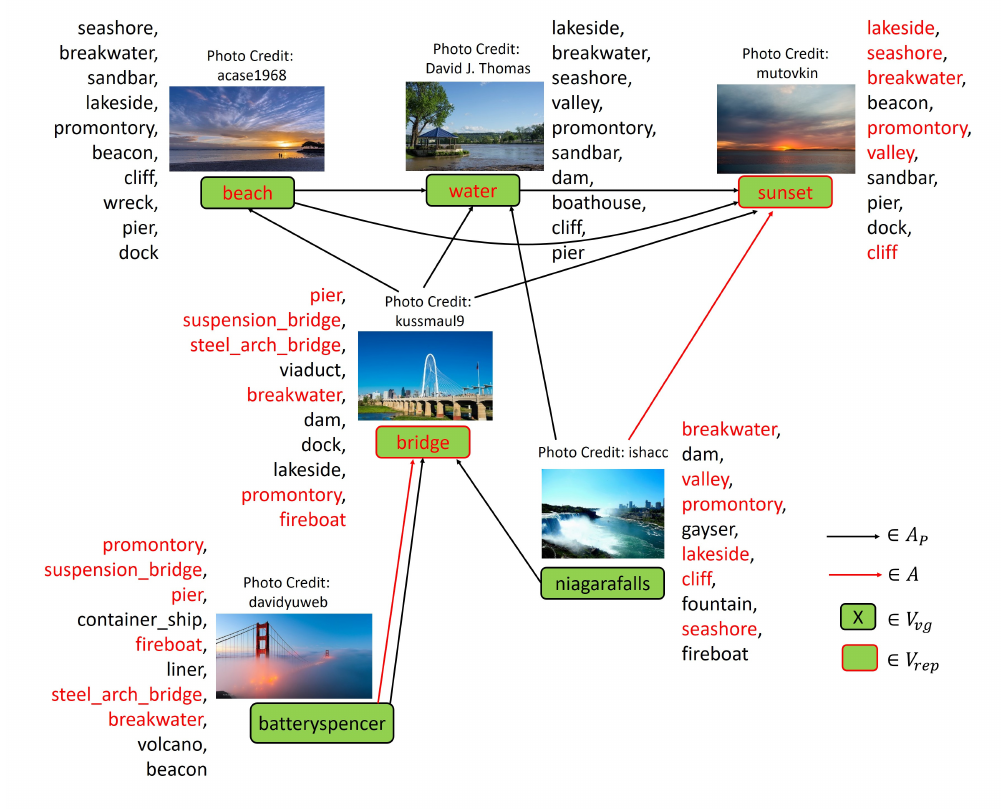
Figure 5. Examples of how the representative visual concepts are determined. A P represented by black lines is a set of edges between each concept and its parent nodes. For each visual geospatial concept, the furthest either directly or indirectly reachable visually similar concepts, which are to be its representative visual concepts, are searched by using these